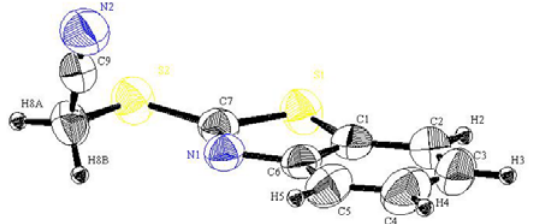
Figure 1. Perspective view and atom labeling of the X-ray structure of compound 2